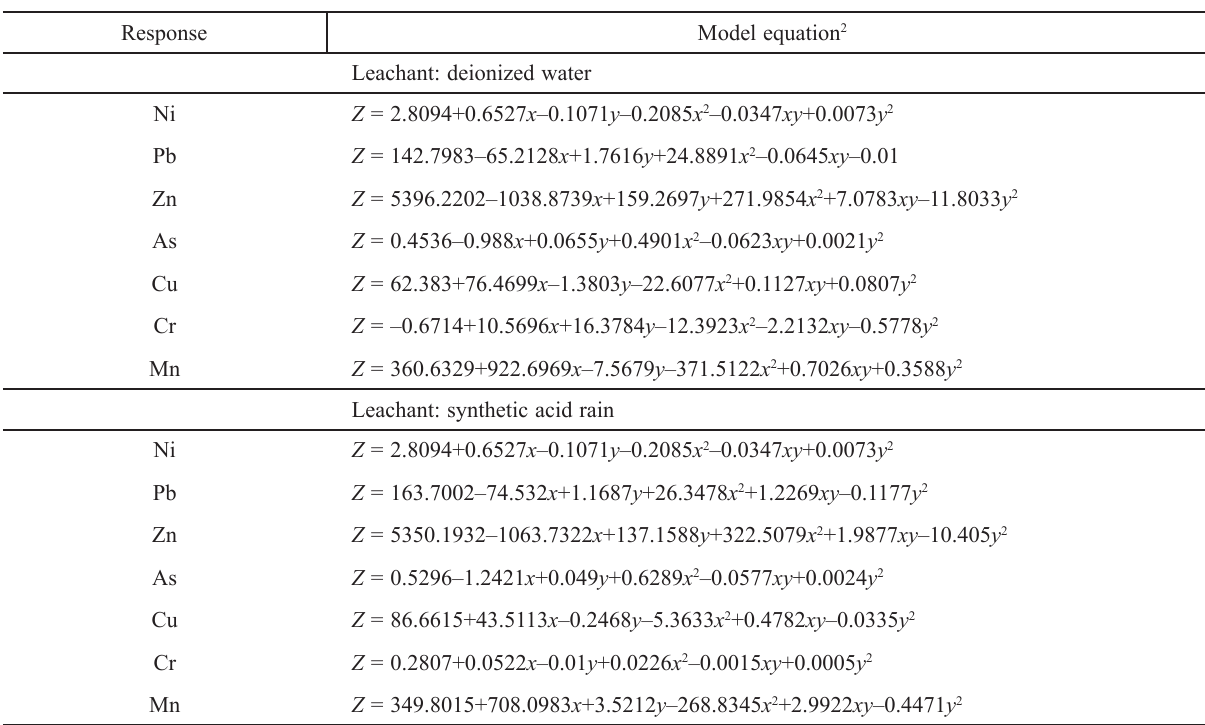
Table 4 – Polynomial equations fitted to the results of major elements concentration leached in deionized water and synthetic acid rain as leachant